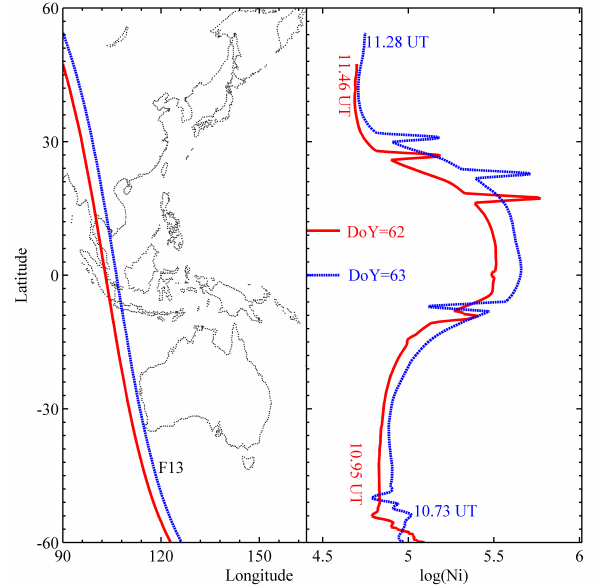
Fig. 6. (Left) Trajectories of DMSP F13 spacecraft during the 3 March (red solid trace) and 4 March (blue dotted trace) 2001 pas- sage over the TEC enhancement region. (Right) DMSP F13 obser- vation of plasma density in the topside ionosphere during 10.73– 11.28UT on 4 March (blue dotted trace) 2001 and during 10.95– 11.46UT on 3 March (red solid trace)